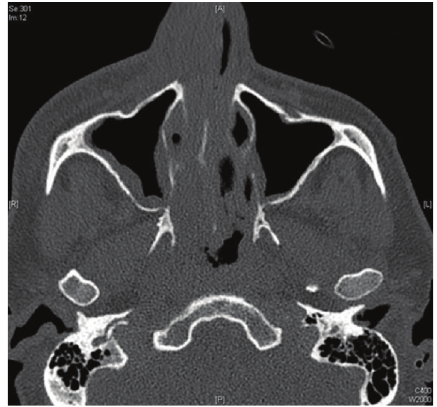
Figure 2: Sagittal CT view of sinuses showing thickening of the mucosa of the anterior right side septum and soft tissue thickening overlying the right side nose and cheek.